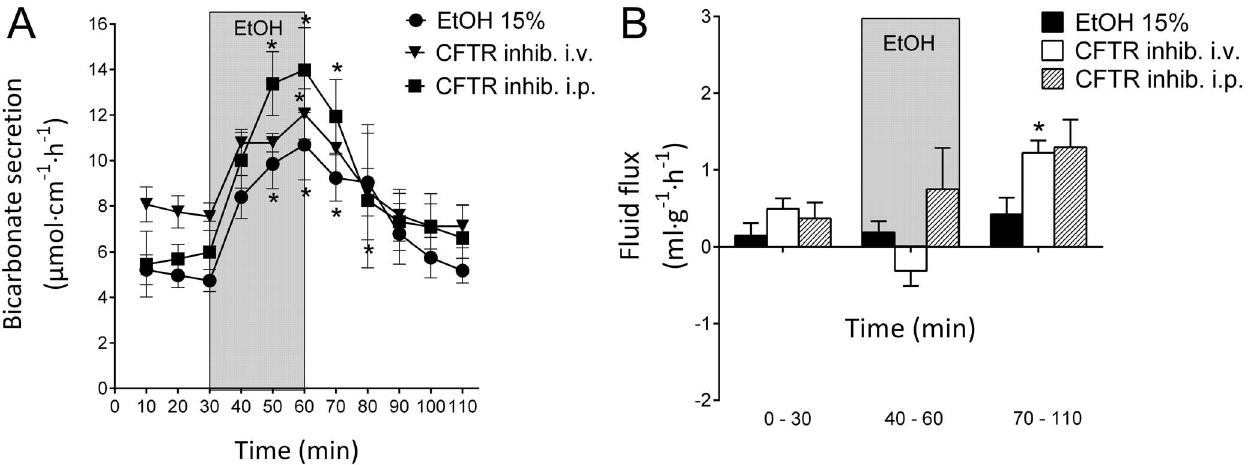
Figure 2. Effects of CFTR inhibition on ethanol-induced increases in duodenal bicarbonate secretion and fluid flux. A). The effects of luminal perfusion of the duodenum with 15% ethanol (n=11), 15% ethanol pretreated with CFTR inh-172 i.v. (n=6) and 15% ethanol pretreated with CFTR inh-172 i.p. (n=4) on duodenal bicarbonate secretion. Neither the i.v. nor i.p. administration of CFTR inh-172 had any effect on the ethanol-induced increase in duodenal bicarbonate secretion. B). Neither the i.v. nor i.p. administration of CFTR inh-172 had any effect on the basal or ethanol-stimulated fluid flux. However, in animals administered CFTR inh-172 i.v., the net fluid flux increased after ethanol perfusion. The values are the mean 6 SEM. * indicates a significant (p , 0.05) increase compared with baseline in the same